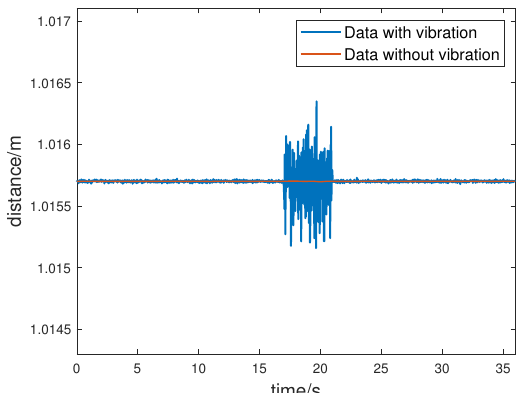
Figure 14. Experiment of track settlement measurement under simulated vibration